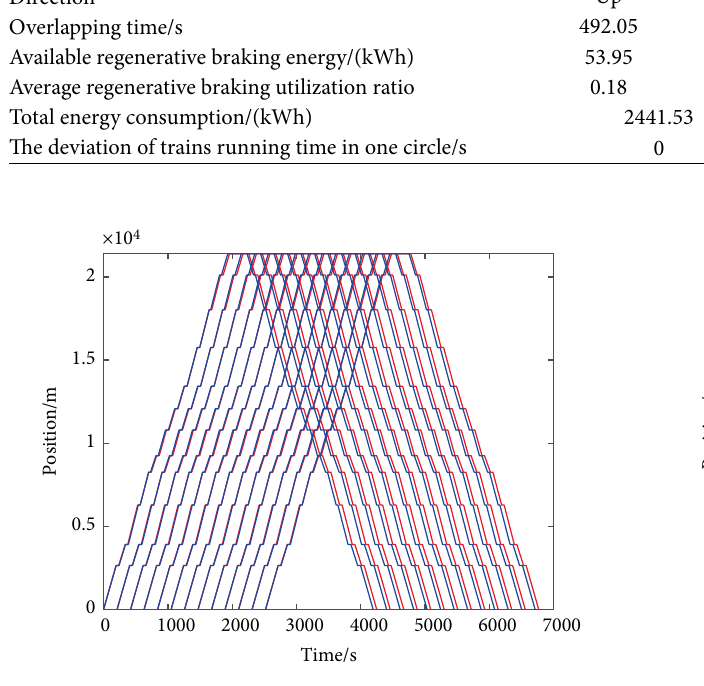
Figure 14: A comparison of the CUT (red lines) and the OQOST (blue